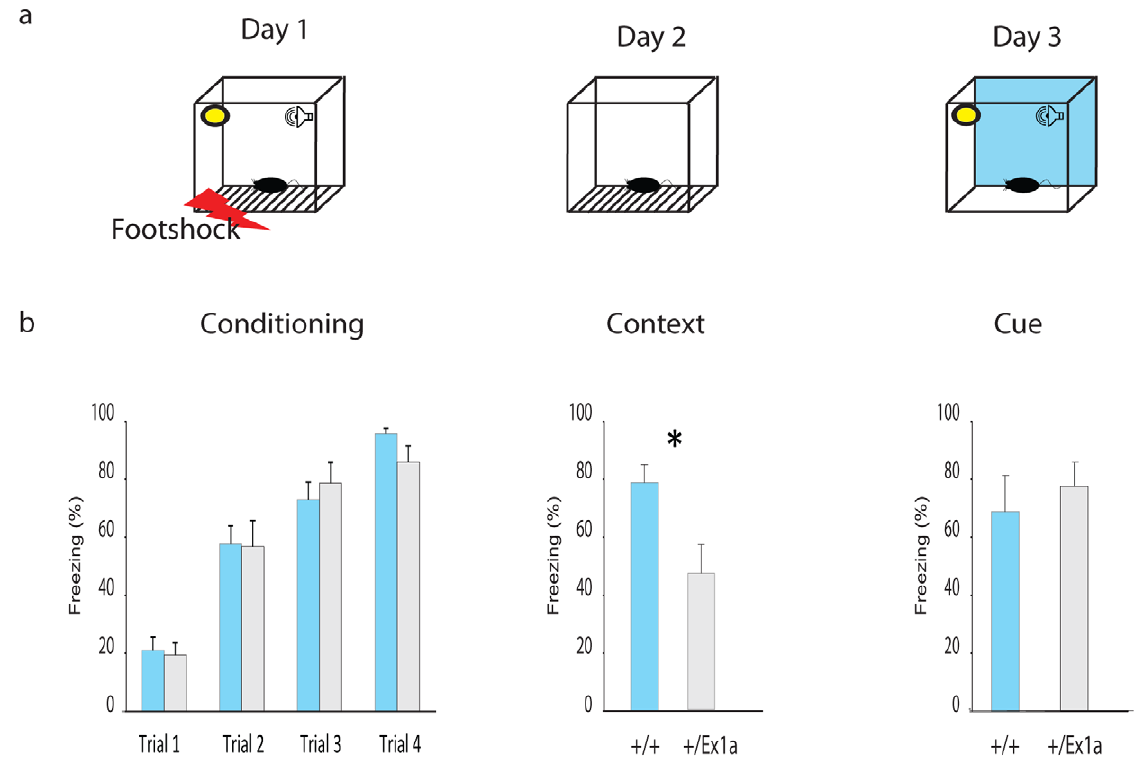
Figure 4. Fear conditioning performance. (a) Representation of the FC protocol over three days and three different experimental phases (Conditioning, Context and Cue). (b) Mean percentage values of freezing behavior 6 s.e.m. are plotted for each experimental phase. Statistics are reported as following: t -test; *= P , 0.05.